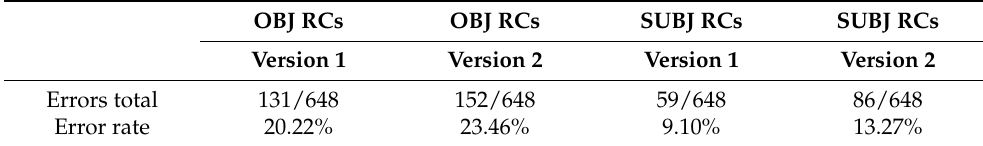
Table 4. Case and the extraction site of the relativized